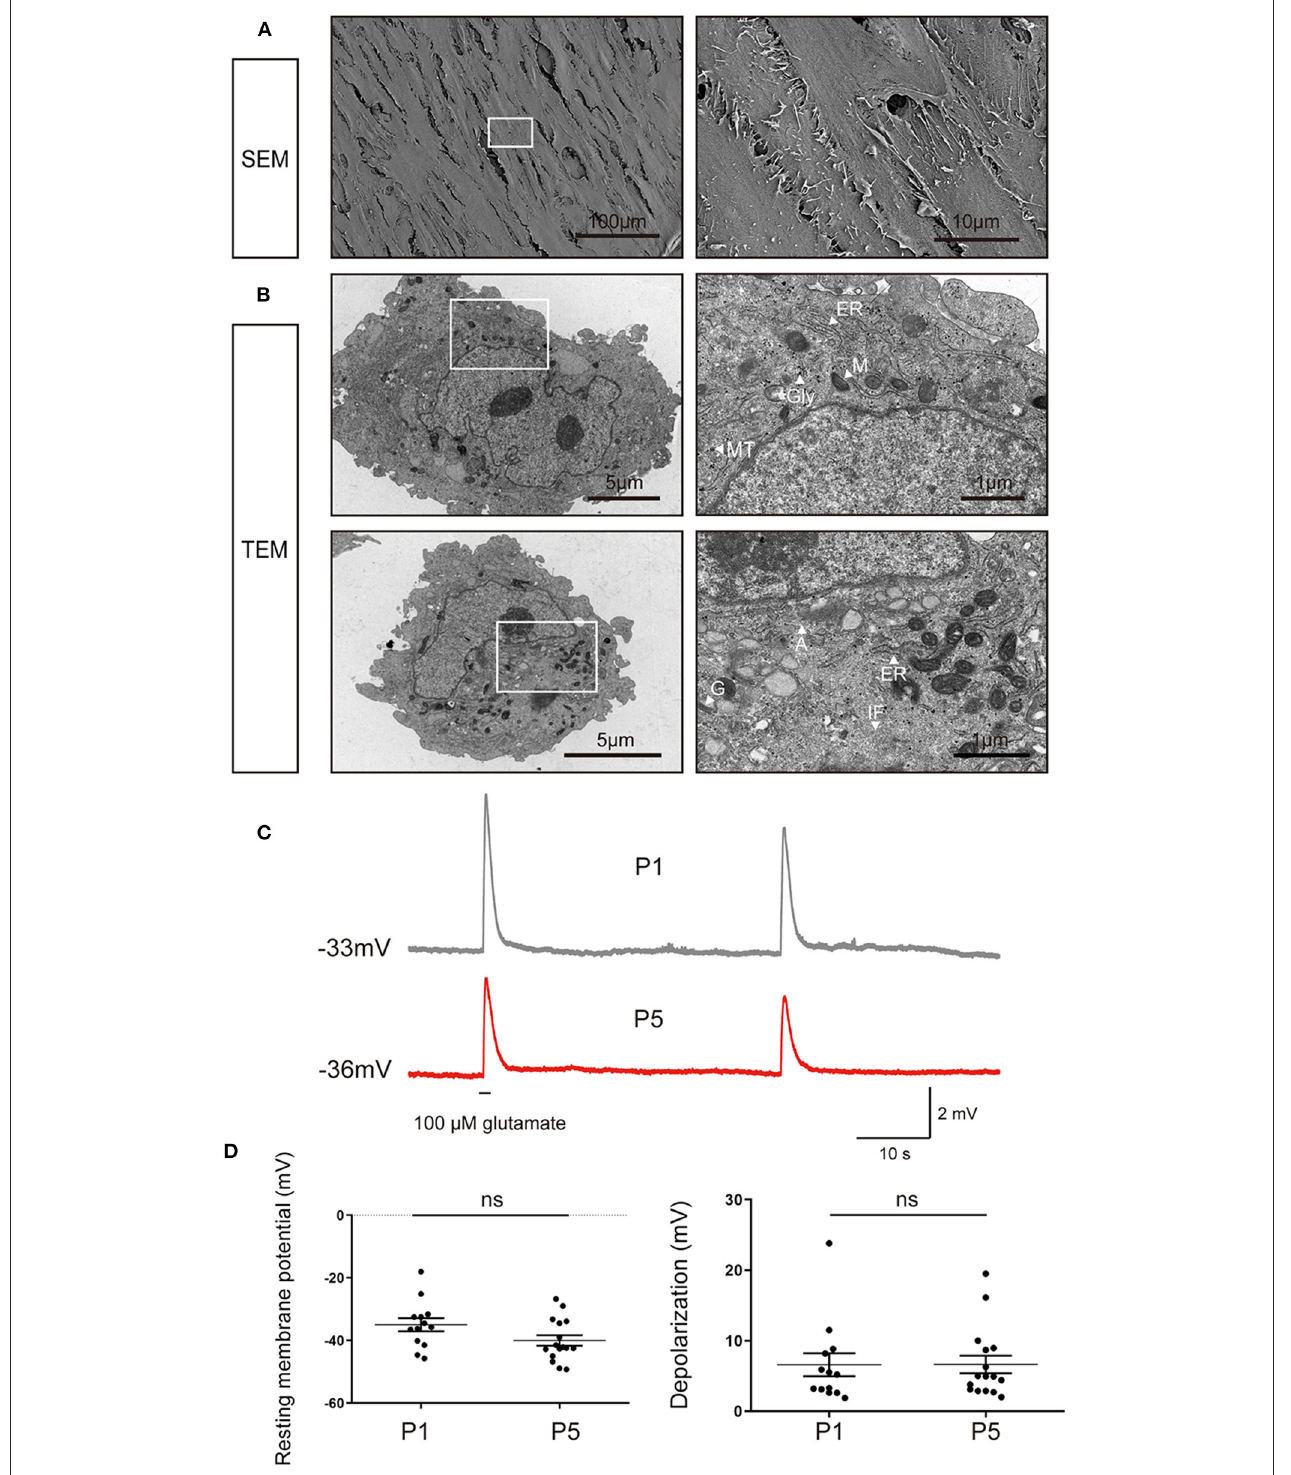
FIGURE 6 | Ultrastructural and electrophysiological characteristics of the passaged iMGCs. (A) SEM images showed the iMGCs possessed a typical spindle-like morphology with many microvillus. (B) TEM images showed the iMGCs with abundant mitochondria (M), endoplasmic reticulum (ER), Golgi apparatus (G), glycogen (Gly), microtubules (MT), intermediate filaments (IF) and actins (A) in the cytoplasm. (C) Both P1 and P5 iMGCs depolarized after application of L-glutamate in current-clamp recordings. (D) P1 and P5 iMGCs presented no significant difference in resting membrane potential and the magnitude of depolarization. SEM, scanning electron microscope; TEM, transmission electron microscope; P1 and P5, passage 1 and 5; ns, no significance.